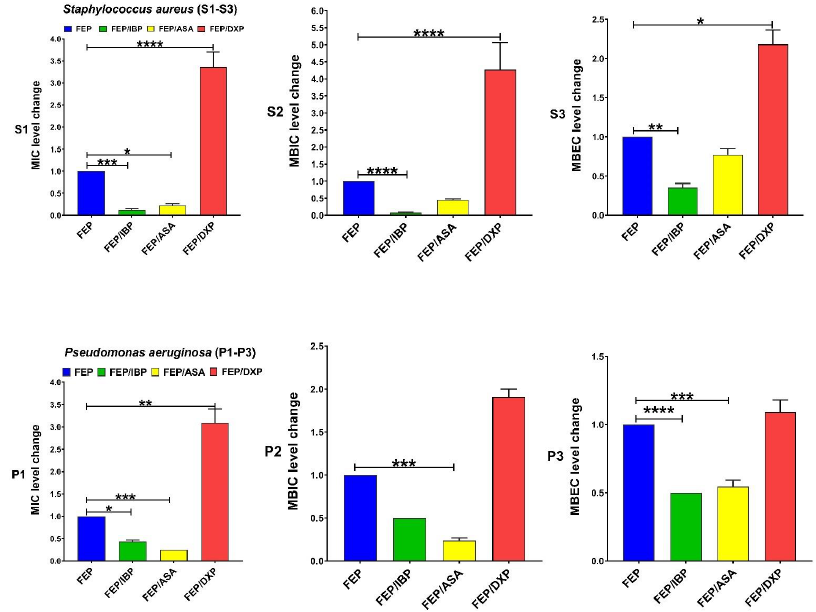
Figure 5. Effects of sub-MICs of Ibuprofen (IBP: 200 µg/mL), aspirin (ASA: 200 µg/mL), and dexa- methasone sodium phosphate (DXP: 500 µg/mL) on the levels of MIC, MBIC, and MBEC of cefepime (FEP) for clinical isolates. Graphs were drawn based on fold changes of MIC, MBIC, and MBEC for FEP in combination with sub-MICs of IBP, ASA, and DXP on clinical isolates. Data are displayed as the mean ± standard error of the mean from 3 replicate experiments and were analyzed using ANOVA and nonparametric Kruskal – Wallis test. See S1 – S3 for S. aureus isolates and P1 – P3 for P. aeruginosa isolates . IBP significantly decreased the levels of MIC, MBIC, and MBEC for FEP among clinical isolates of S. aureus and MIC and MBEC among P. aeruginosa isolates . ASA significantly decreased MIC of FEP among clinical isolate S. aureus and MIC and MBIC of FEP among P. aeru- ginosa . DXP significantly increased the MIC, MBIC, and MBEC of FEP among clinical isolates of S. aureus and MIC among clinical isolates of P. aeruginosa . *, statistical significance with p ≤ 0.05; **, statistical significance with p ≤ 0.01; ***, statistical significance with p ≤ 0.001; and ****, statistical significance with p ≤ 0.00 01. Analysis of qPCR experiment results showed changes in the transcriptional levels of icaA and algD in the presence of 200 µg/mL IBP and ASA and 500 µg/mL DXP compared to the control group. The expression level of icaA significantly decreased in the presence of IBP compared to the control. Although the transcriptional level of icaA was decreased in the presence of ASA, it was not significant. The expression level of icaA in clinical iso- lates of S. aureus in the presence of DXP significantly increased compared to the control (Figure 6). Transcriptional levels of algD in P. aeruginosa isolates in the presence of IBP and ASA were significantly decreased compared to the control group, and expression levels of algD significantly increased in the presence of DXP (Figure 6).